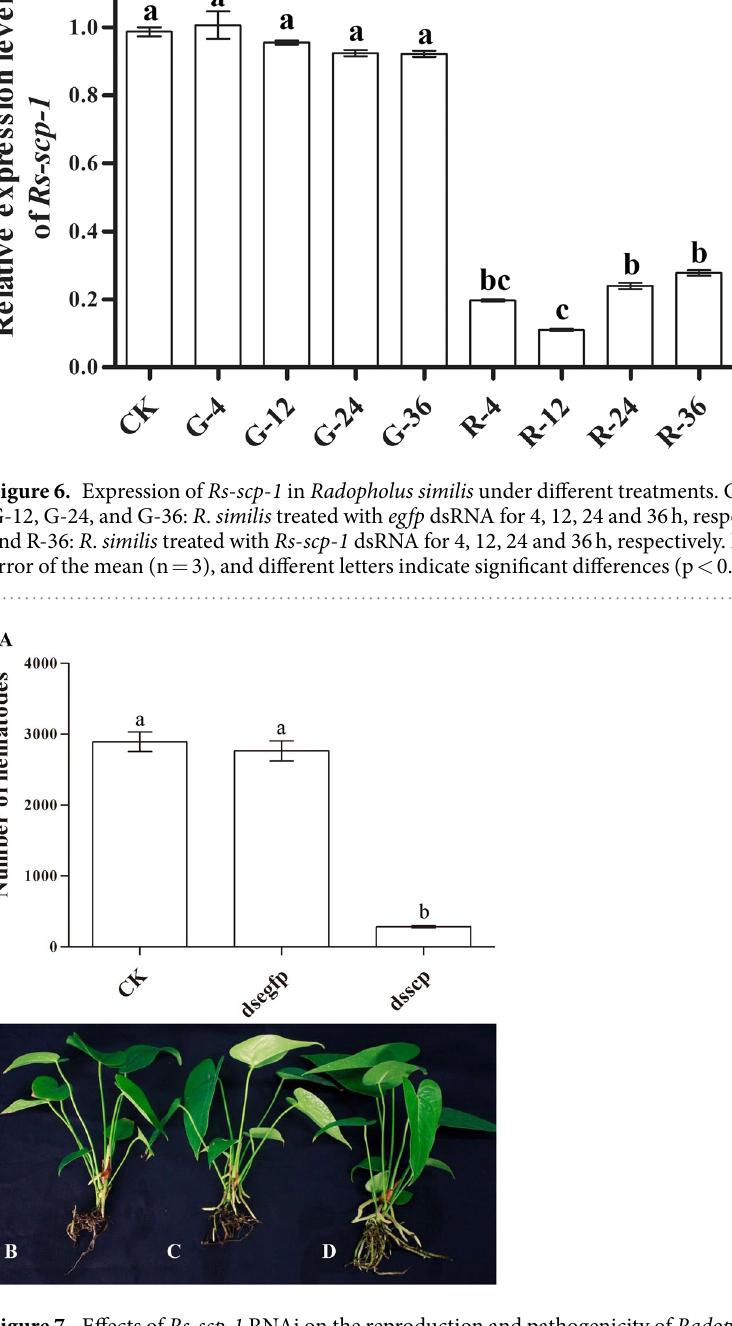
of R . similis gDNA was digested with EcoR I and Hind III (Thermo Fisher) overnight at 37 °C. The digested DNA was separated via electrophoresis and transferred to a Hybond N + membrane (Amersham Biosciences, GE Healthcare, UK). Hybridization and detection were performed using a Dig High Primer DNA Labeling and Detection Starter Kit I (Roche Applied Science) at 48 °C for 24 h. pTA2-gscp digested with EcoR I and Hind III was used as a control.